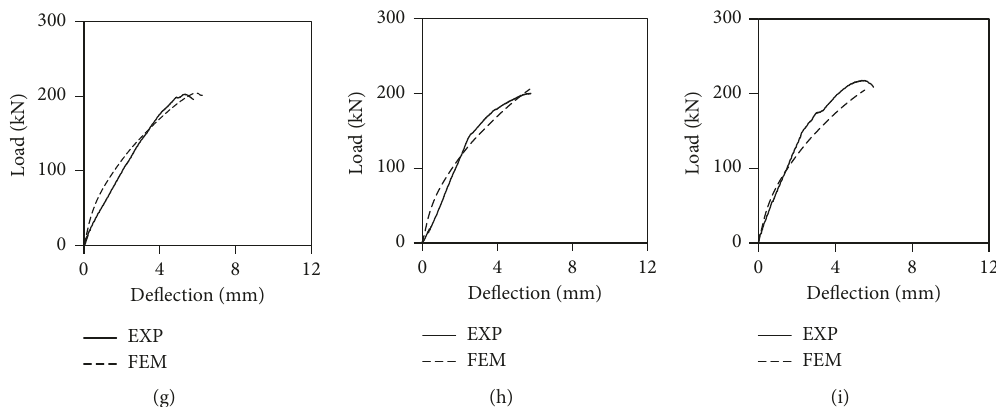
Figure 17: Load-midspan deflection comparison for tested beams. (a) Control beam. (b) 1.5F-Epoxy. (c) 0F-8D12. (d) 1F-8D12. (e) 1.5F- 8D12. (f) 1.5F-4D12. (g) 1.5F-6D12. (h) 1.5F-6D10. (i) 1.5F-8D10.